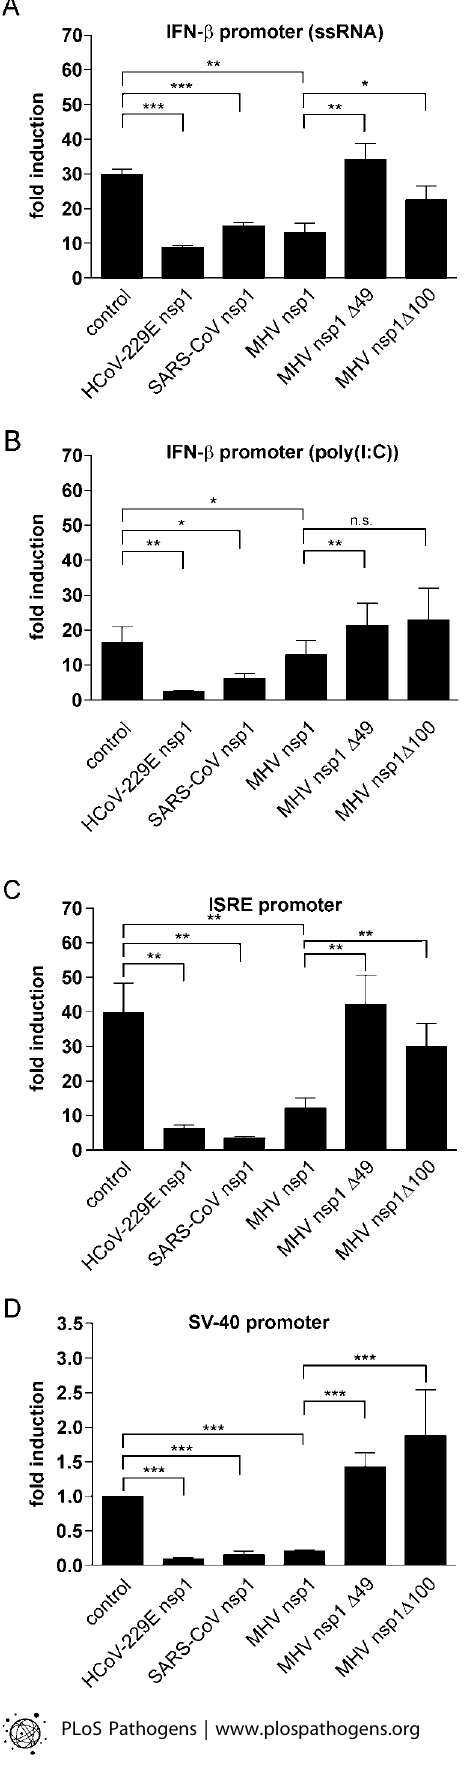
Figure 1. Coronavirus nsp1 Reduces Cellular Gene Expression (A–C) 293 cells were transfected with p125-Luc reporter plasmid ([A, B]; IFN- b promoter), or p(9–27)4tkD( (cid:3) 39)lucter reporter plasmid ([C]; ISRE promoter) and cotransfected with pRL-SV40, and an expression plasmid encoding a full-length coronavirus nsp1 of HCoV-229E, SARS-CoV, or MHV, or a truncated MHV nsp1 variant (49-nt or 100-nt 3 9 end truncations, respectively). At 8 h post transfection, cells were treated with viral single-stranded RNA containing 5 9 triphosphates (A) or poly(I:C) (B), or IFN- a (C), and 16 h later luciferase activity was measured. Firefly luciferase activity was normalized to renilla luciferase activity and indicated as fold induction compared to that of control plasmid- transfected cells (control). (D) 293 cells were transfected with pRL-SV40 and the indicated expression plasmids. Then, 24 h post transfection, luciferase activity was measured. Results represent the mean 6 SD of at least four independent experiments. Statistical analysis was performed using paired Student’s t -test (***, p , 0.001; **, p , 0.01; *, p , 0.05; n.s. (not significant), p . 0.05).